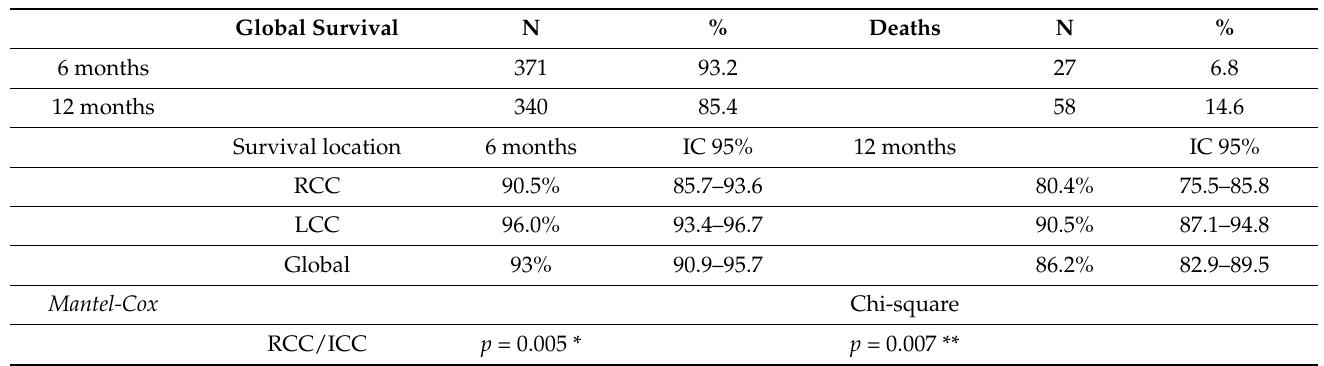
Figure 1. Differences in survival between RCC and LCC. Table 4. Survival